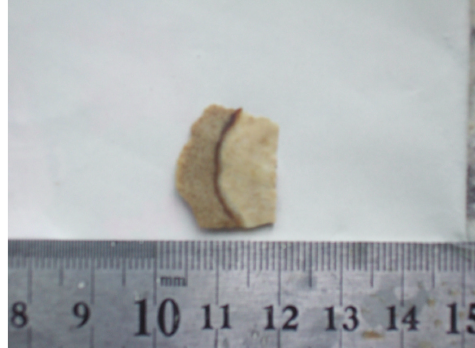
Figure 2: There was a nodule with clear boundary into the gross